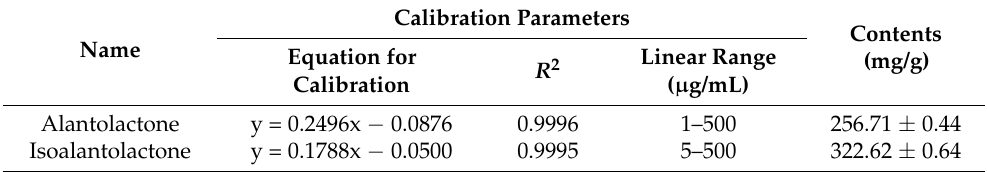
Table 2. Calibration parameters and alantolactone and isoalantolactone content in SFIH using LC- UV.